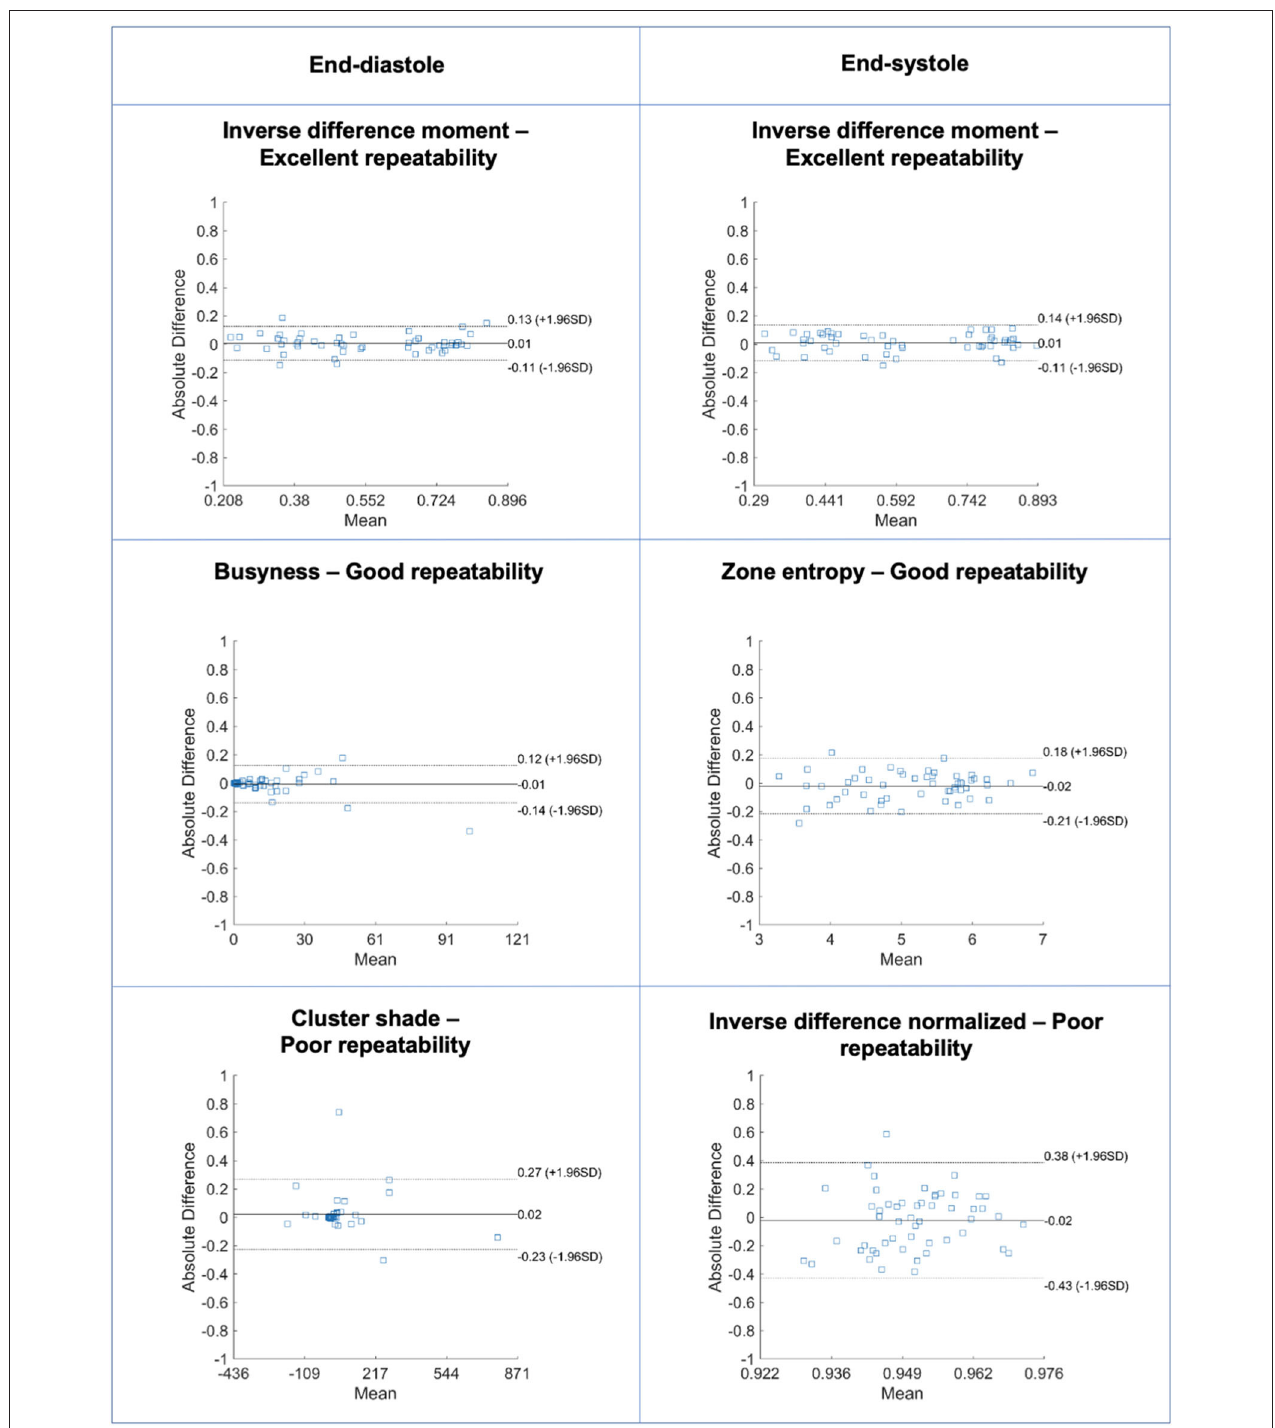
FIGURE 8 | Bland-Altman plots for selected LV myocardium texture features in end-diastole (left) and end-systole (right) with different levels of repeatability. Differences in Bland-Altman are calculated after normalizing radiomics in the range [0–1] to facilitate comparison among different features. All features are unitless. LV: left ventricle. extraction and image normalization may improve robustness of radiomics features, in particular for intensity-based